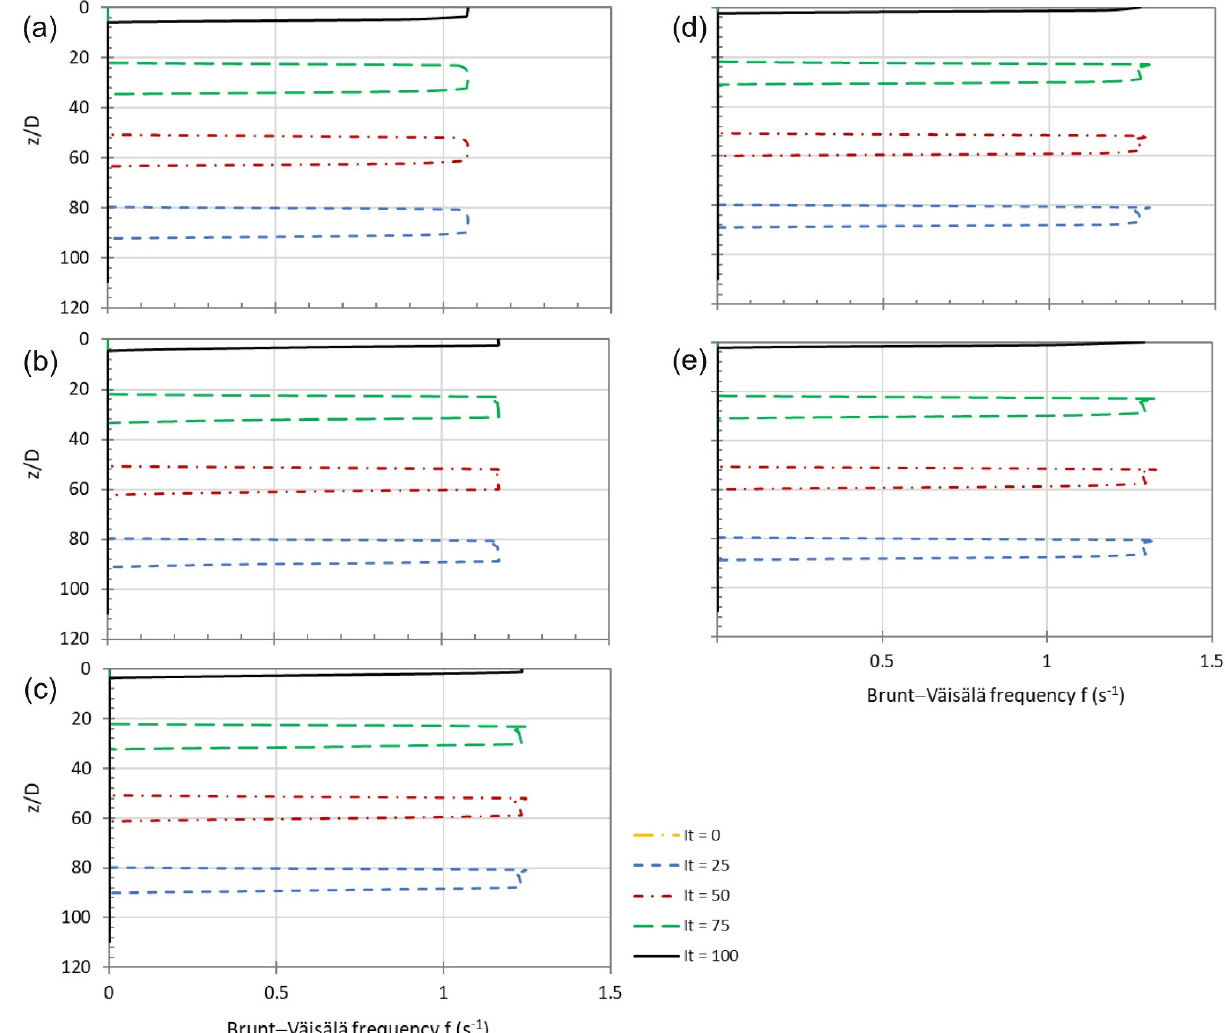
Figure 8. Occurrences of Brunt–Väisälä frequency f (s − 1 ) of the stratified layer sequence under the uniform room air temperatures with respect to the dimensionless vertical distance z / D from the exit of the air-conditioning device for the cycles after 25 (it = 25), 50 (it = 50), 75 (it = 75) and 100 (it = 100) cycle calculations for: ( a ) θ 0 = 15 ◦ ; ( b ) θ 0 = 30 ◦ ; ( c ) θ 0 = 45 ◦ ; ( d ) θ 0 = 60 ◦ ; and ( e ) θ 0 = 75 ◦ . Note that there is not any occurrence during the first cycle (it = 0).